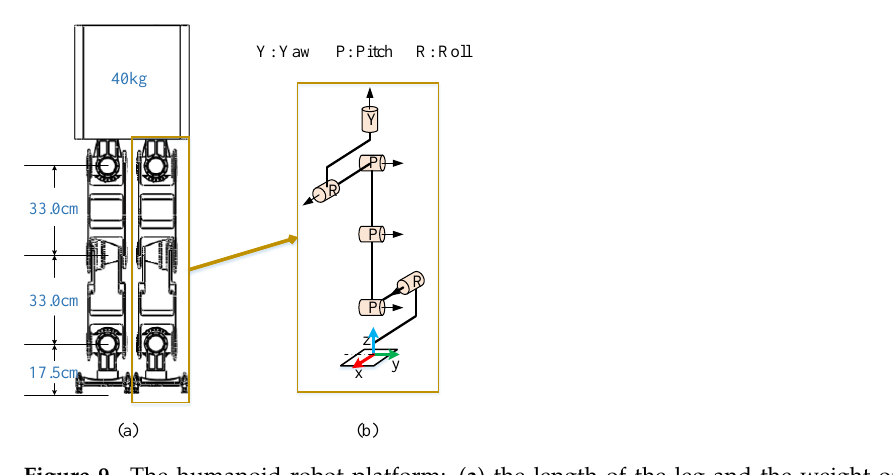
Figure 9. The humanoid robot platform: ( a ) the length of the leg and the weight of the trunk; ( b ) configuration of the DOFs of a leg and the direction of the